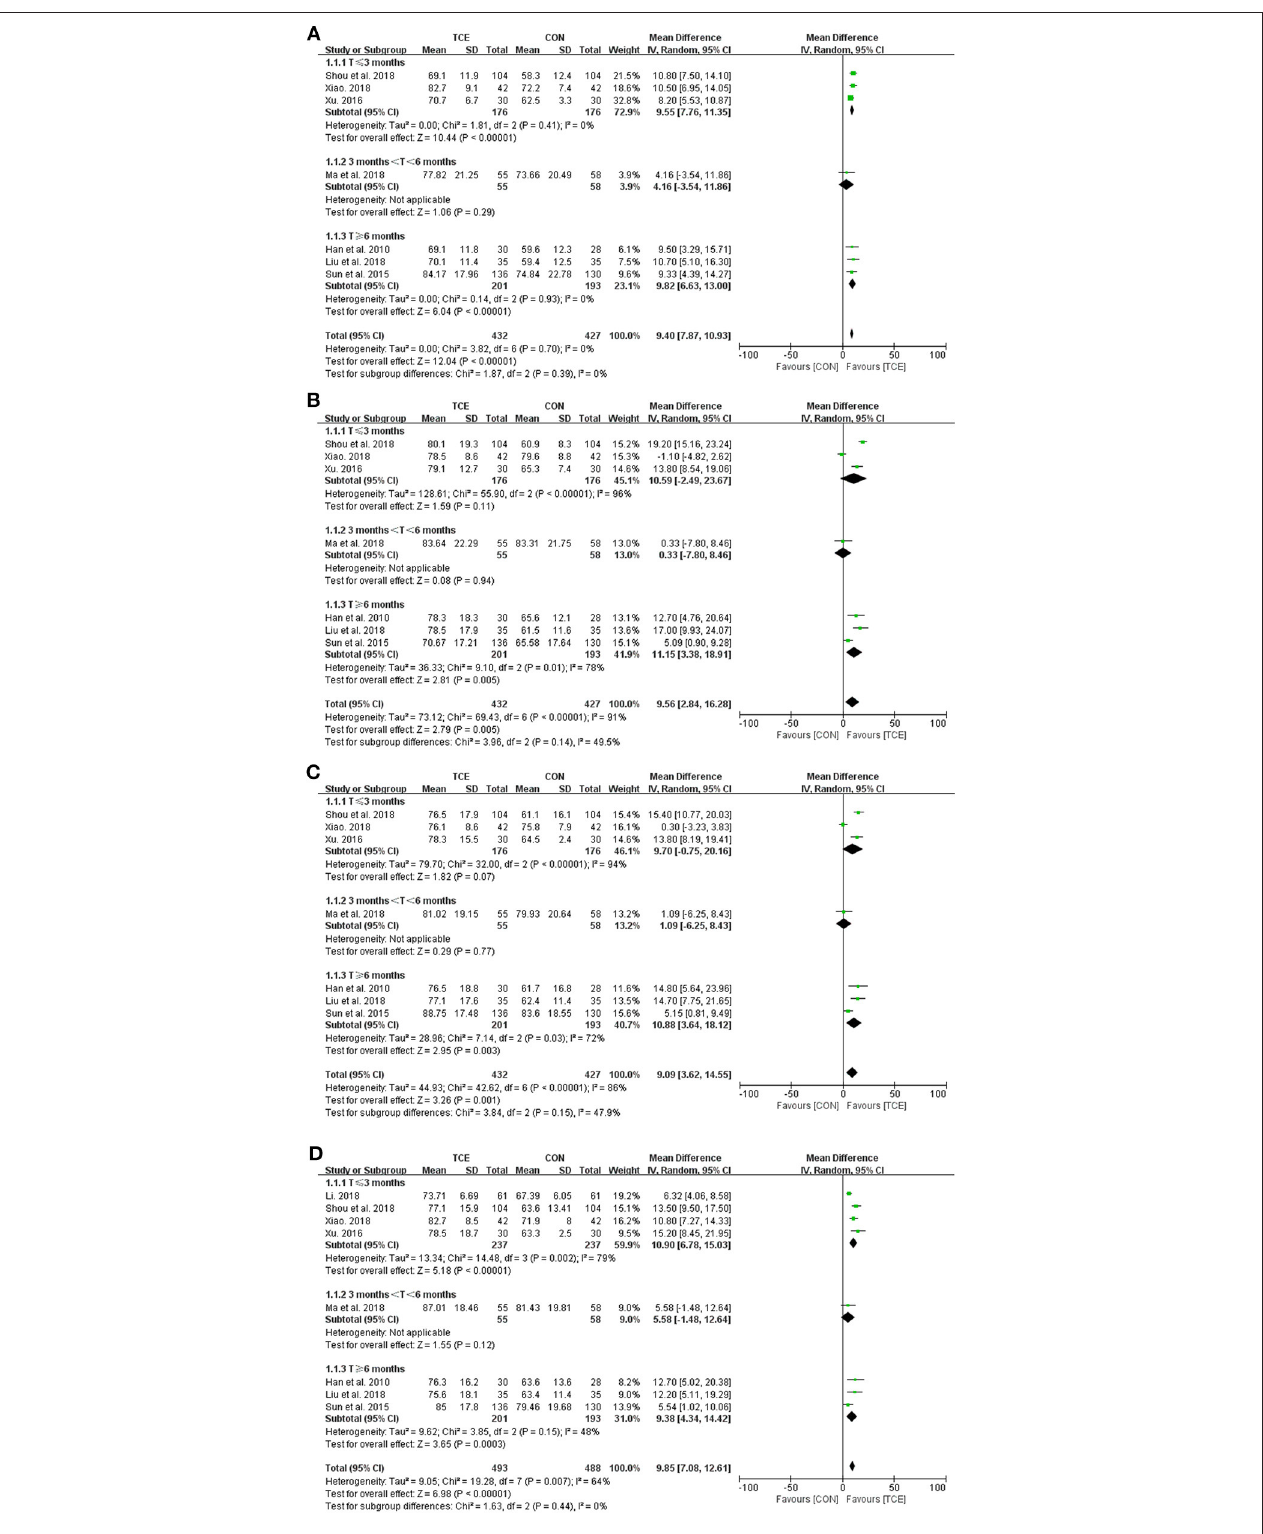
FIGURE 5 | Meta-analysis of SF-36 QOL (mental component) in the TCE group (Tai Chi) vs. the control group. (A) Vitality; (B) social function; (C) role emotional; and (D) mental health. TCE, traditional Chinese exercises; CON, control; SD, standard deviations; CI, confidence intervals; IV, inverse variance.